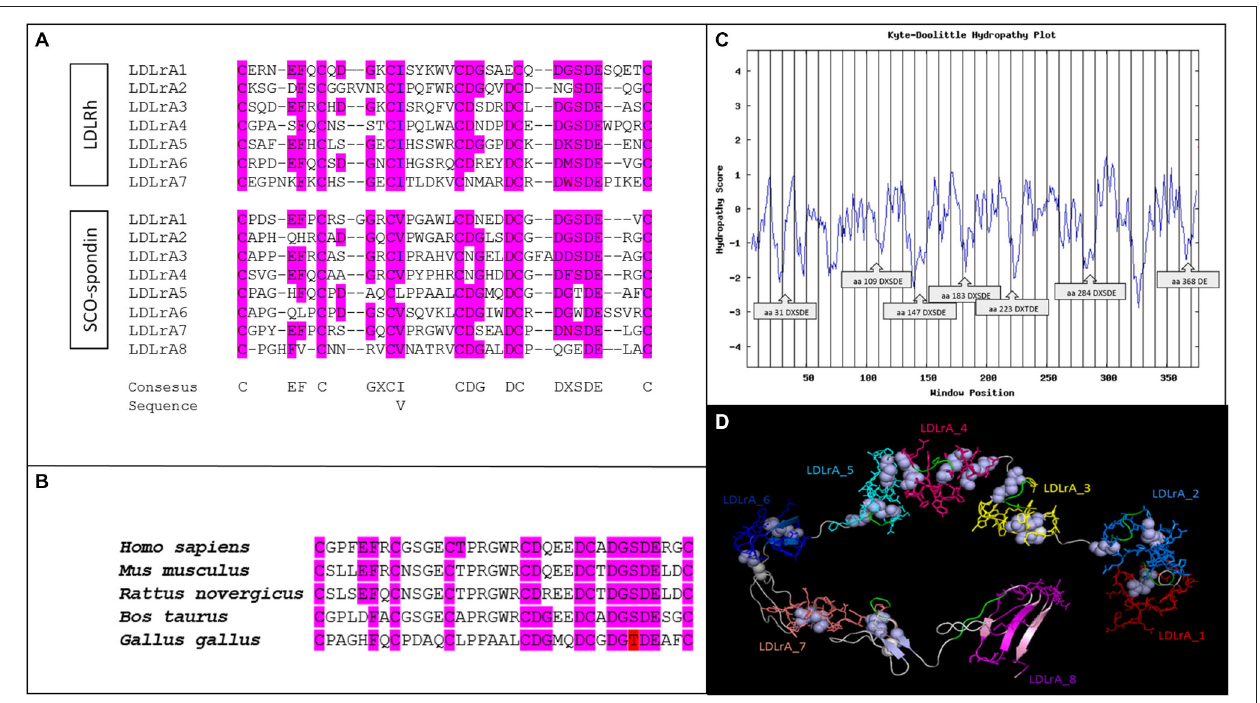
to threonine (in red). (C) Hydropathic plot of the SCO-spondin sequence that contains the LDLrA domains, showing its hydrophilic character, especially for the regions containing the DxSDE motifs. (D) Tertiary structure of the SCO-spondin region that contains the LDLrA domains arranged in tandem. Each domain is shown in a different color; DxSDE motifs are highlighted in green, and disulfide bridges are in